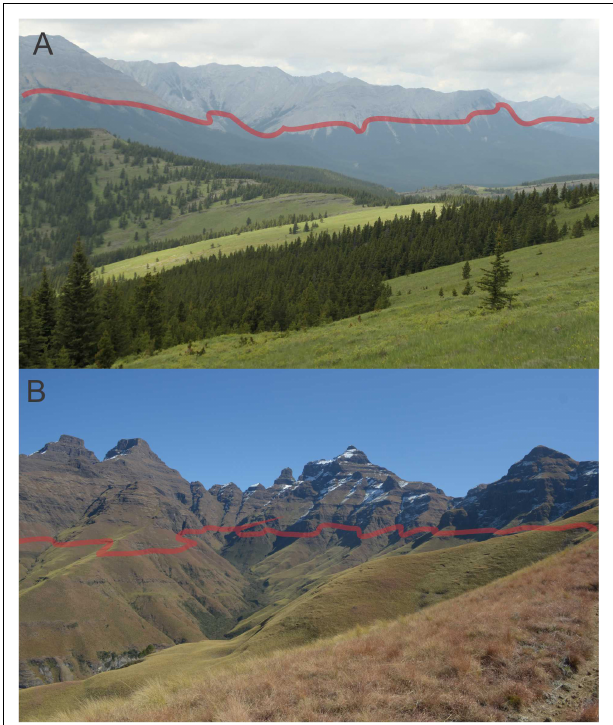
FIGURE 3 | Temperature-related ecological transition zones occurring on mountains. (A) Tree-line at c. 2,100 m on Compression Ridge in the Canadian Rockies. (B) C 3 -C 4 grass-line transition zone at c. 2,500 m on Cathedral Ridge in the Maloti–Drakensberg (Cathedral Peak range, KwaZulu-Natal, South Africa). Pictures taken by S. D.